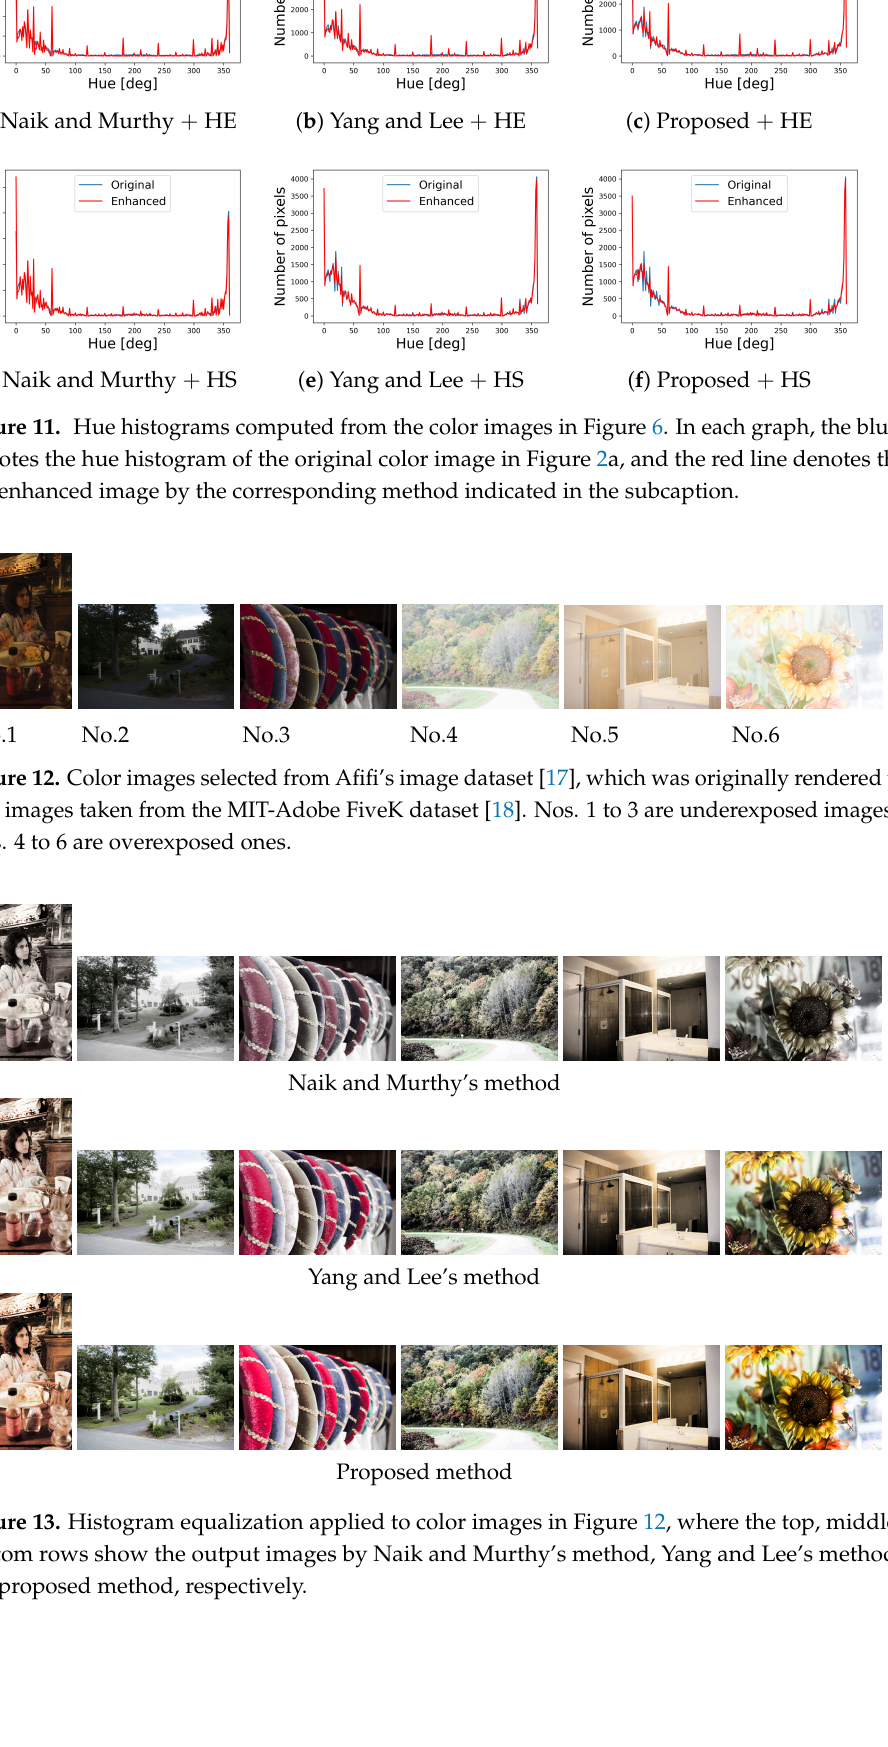
Figure 11. Hue histograms computed from the color images in Figure 6. In each graph, the blue line denotes the hue histogram of the original color image in Figure 3( a ), and the red line denotes that of the enhanced image by the corresponding method indicated in the subcaption.